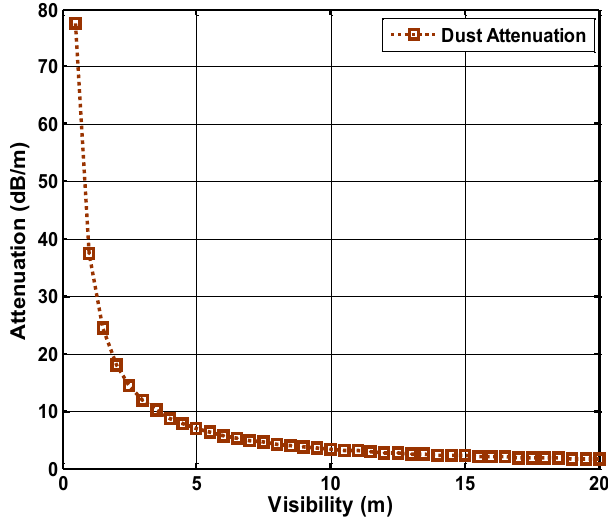
Figure 6. Approximate dust attenuation for VLC link.